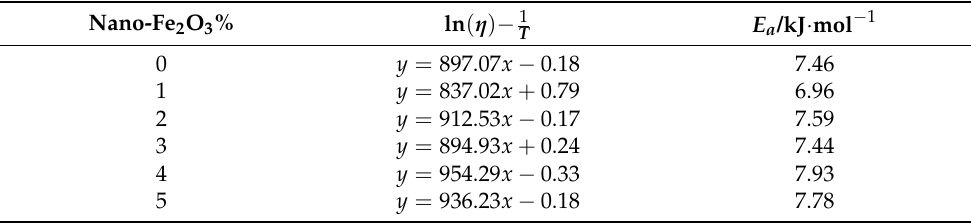
Table 2. Effect of different doping of Nano-Fe 2 O 3 on E_a of asphalt